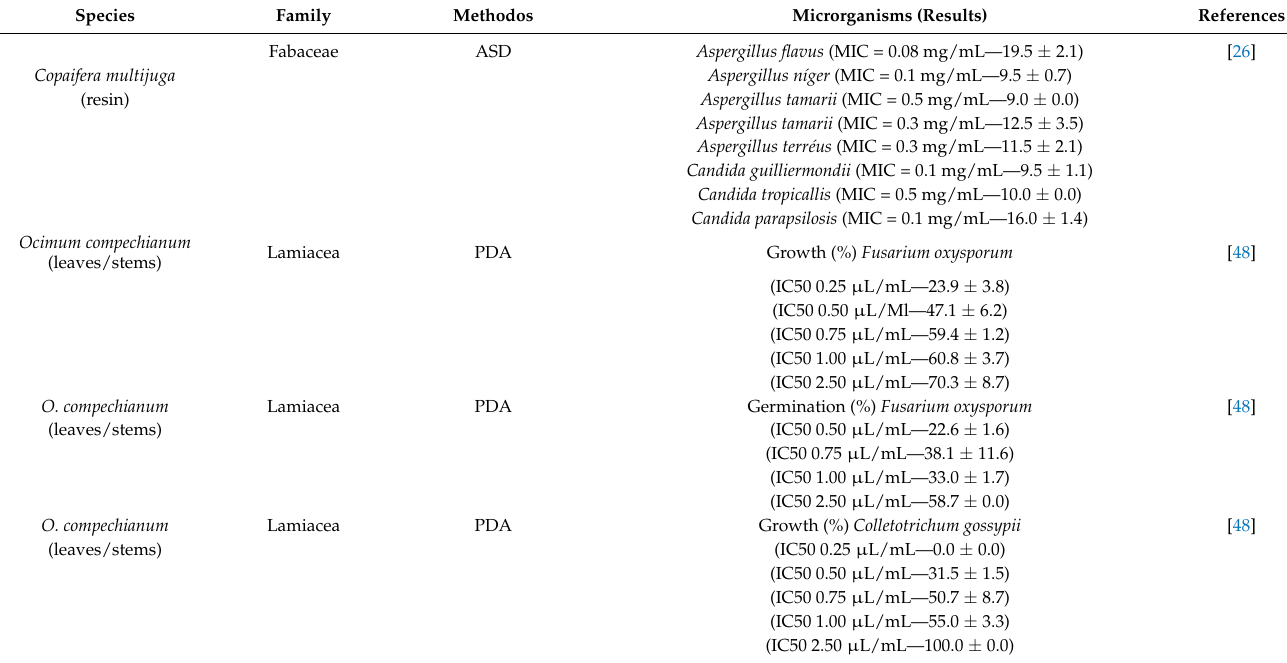
Table 4. Antifungal activity of essential oils from the